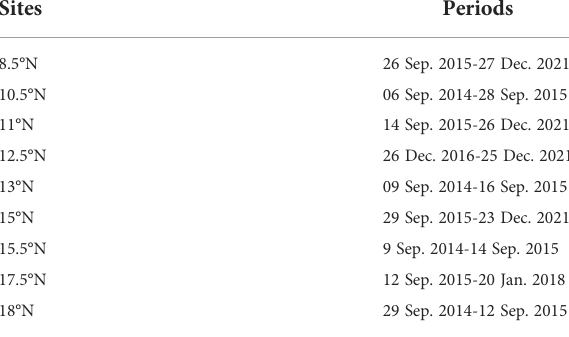
TABLE 1 Mooring locations along 130°E and corresponding ADCP observation